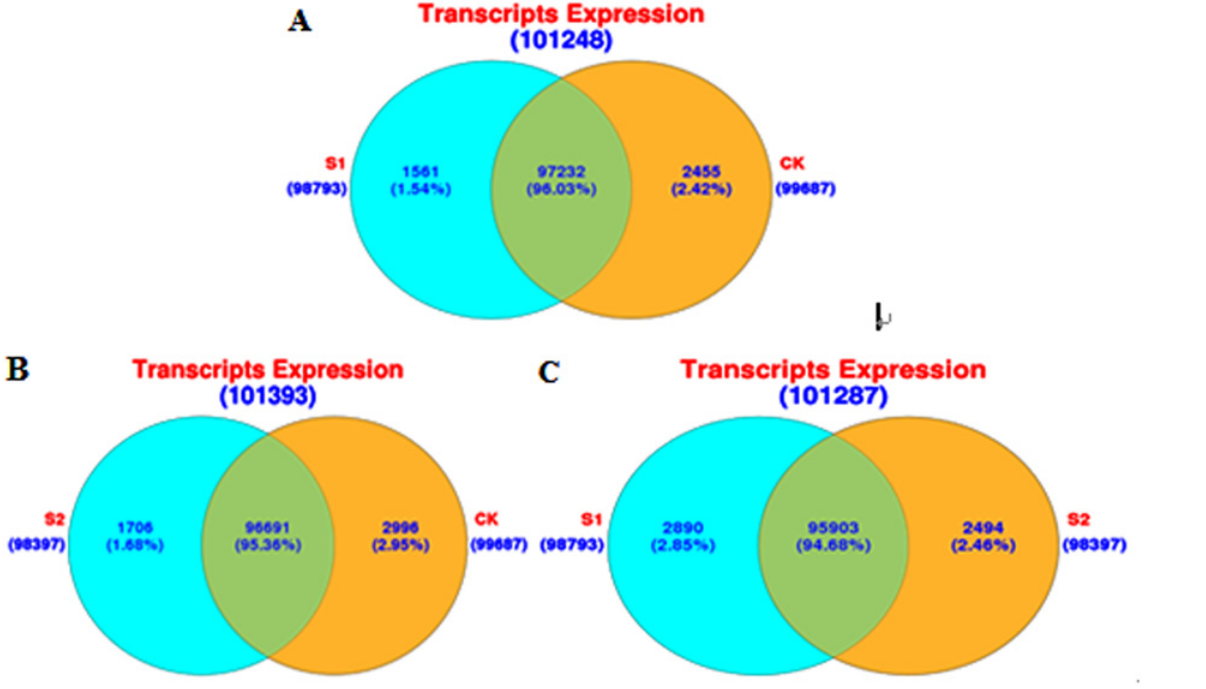
Fig 2. Differential expression pattern of all the transcripts in the control (CK) and two salt treatments (S1, S2) libraries.